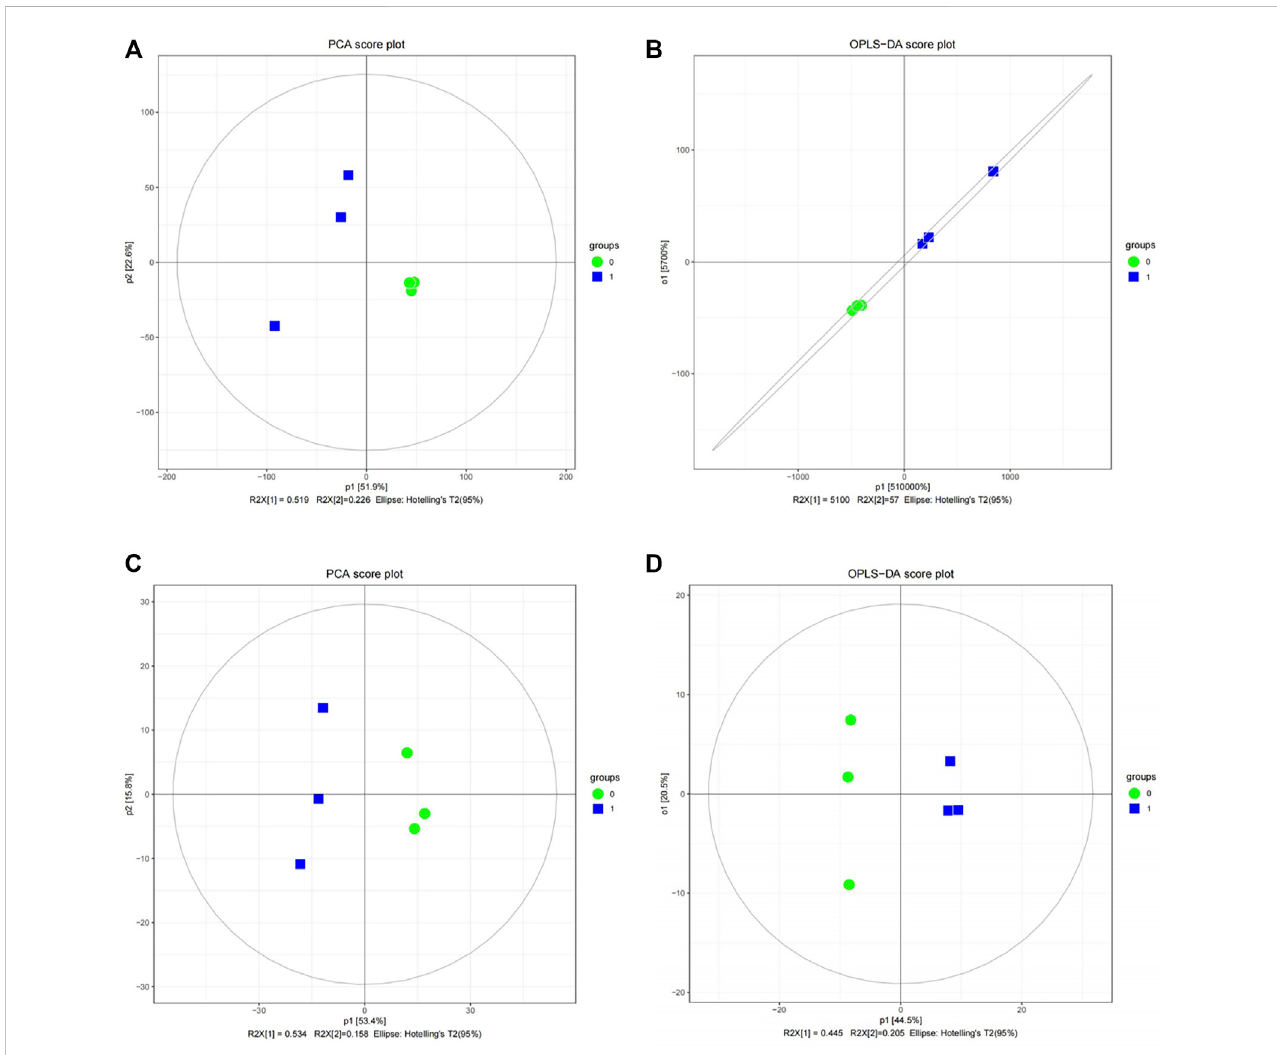
FIGURE 7 Quality analysis of proteomic and metabolome data. (A) Principal component analysis (PCA) score diagram for the differential expression analysis of proteomic data between case and control samples. (B) Orthogonal partial least-squares-discriminant analysis (OPLS-DA) score diagram for the differential expression analysis of proteomic data between case and control samples. (C) PCA score diagram for the differential expression analysis of metabolome data between case and control samples. (D) OPLS-DA score diagram for the differential expression analysis of metabolome data between case and control